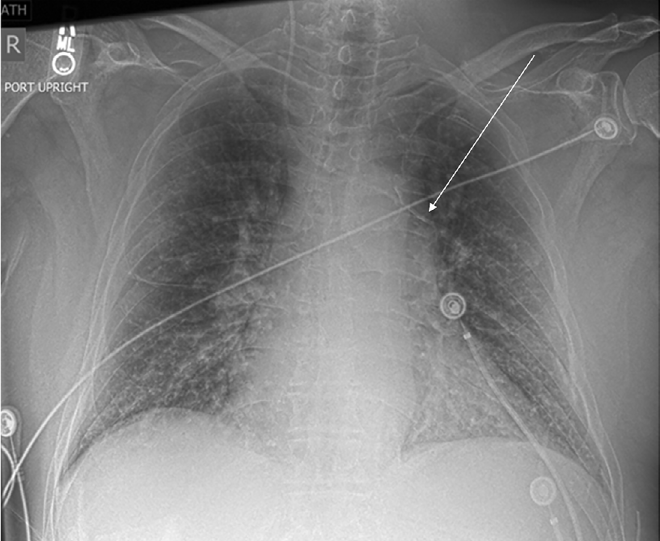
Image 1. Chest radiograph obtained post right-sided internal jugular vein catheter placement, which shows catheter crossing midline right to left terminating within the left atrium